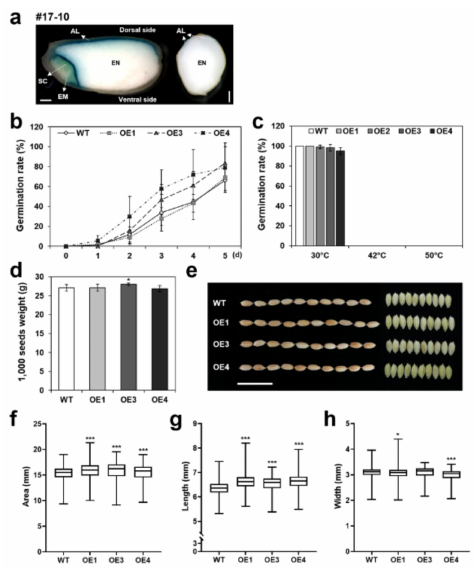
Figure 6. Phenotyping seed dormancy, grain weight, and morphology of OsERF115/AP2EREBP110 - OE transgenic and WT rice plants. ( a ) Histochemical analysis of GUS expression in the seeds of pOsERF115/AP2EREBP110 : GUS transgenic rice plants. The X-Gluc staining of longitudinal (left) and transverse section (right) of transgenic rice seed are shown. SC, scutellum; EM, embryo; AL, aleurone layer; EN, endosperm; Scale bars: 500 µ m. ( b – c ) Germination rates of 35 DAH seeds at 30 ◦ C ( b ) or mature seeds at 30 ◦ C, 42 ◦ C, and 50 ◦ C, respectively ( c ). Data represent mean ( ± SD) three independent experiments with two biological replicates ( n = 30). ( d ) 1000-grain weights of OE and WT plants. Data represent mean ( ± SD) from twenty biological replicates ( n = 100). ( e – h ) Image- based analysis of morphological phenotypes of mature seeds. ( e ) Photographs of OE and WT seeds with husk. Scale bar: 2 cm. ( f ) Surface area, ( g ) length, and ( h ) width of seeds with husk measured by high throughput image analysis. Data represent mean ( ± SD) from 10~30 biological replicates ( n = 100). One-way ANOVA and Fisher’s LSD test were performed by comparing with WT seeds as controls (*, p < 0.05; ***, p <